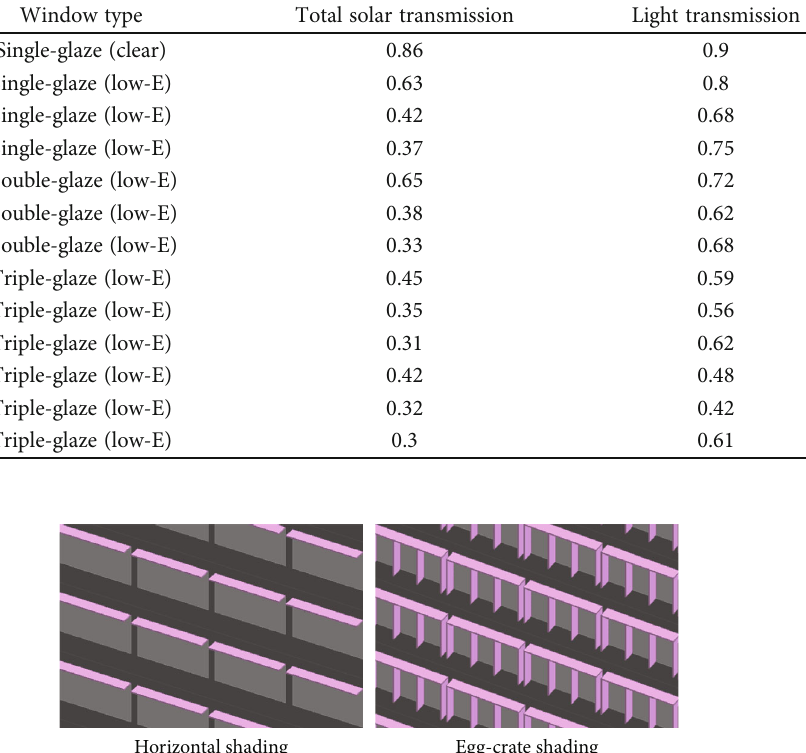
Table 5: Window materials of cases 26 to 37.